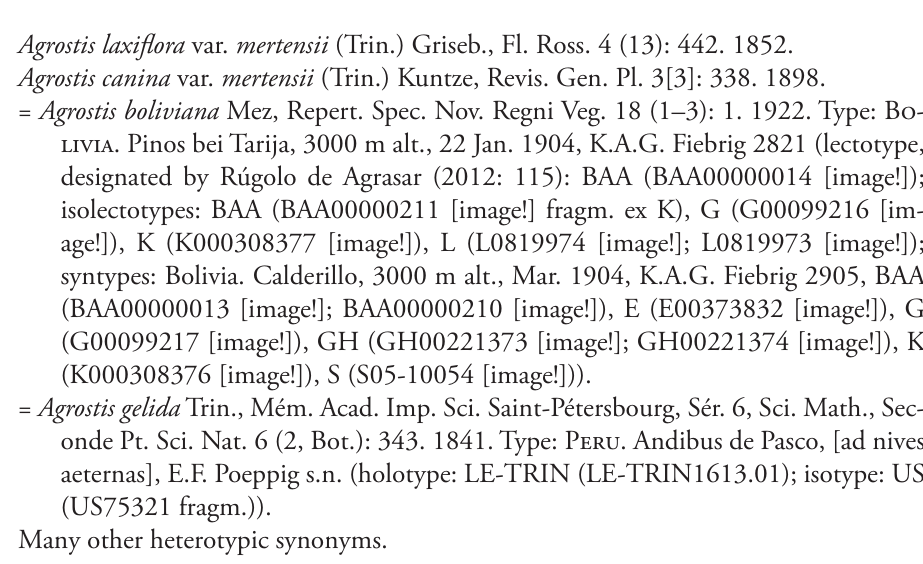
Agrostis laxiflora var. mertensii (Trin.) Griseb., Fl. Ross. 4 (13): 442.